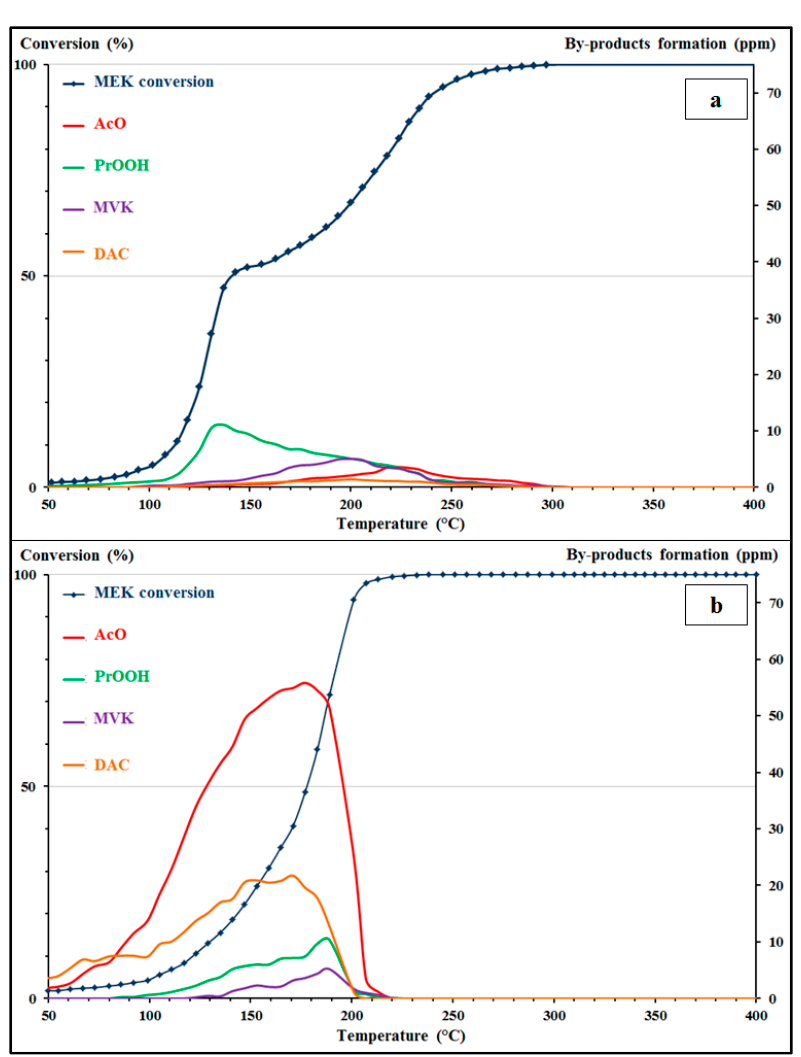
Figure 4. MEK conversion and MEK byproducts formation versus temperature for ( a ) Pd/ γ‐ Al 2 O 3 and ( b ) CoAlCeO catalysts (AcO: acetaldehyde; PrOOH: propionic acid; MVK: methyl ‐ vinyl ‐ ketone; DAC: diacetyl).